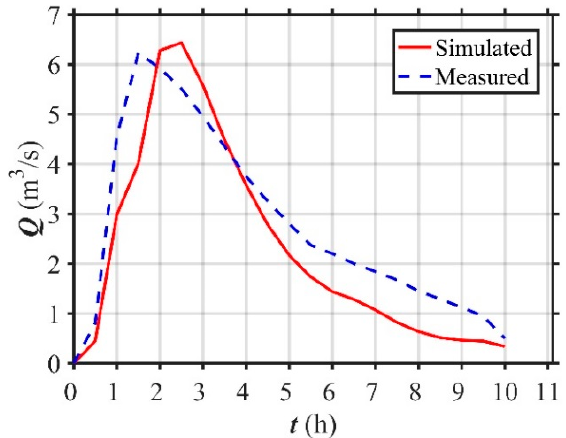
Figure 18. Comparison between the observed and simulated hydrographs.